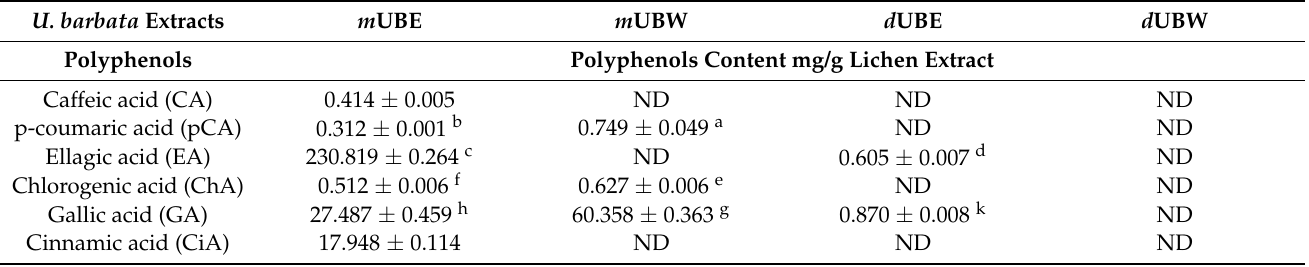
Table 3. Polyphenols contents in U. barbata fluid and dry extracts in ethanol and water.